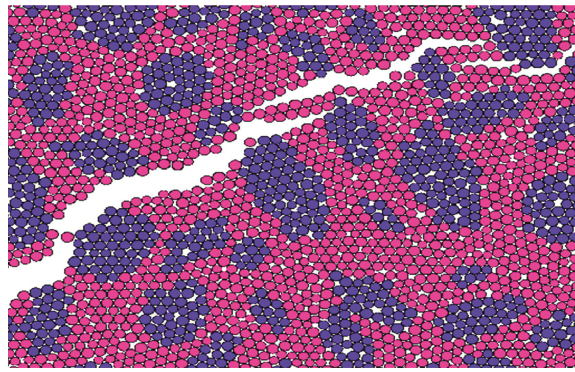
Figure 16: Force chain diagram near the crack in the upper layer.